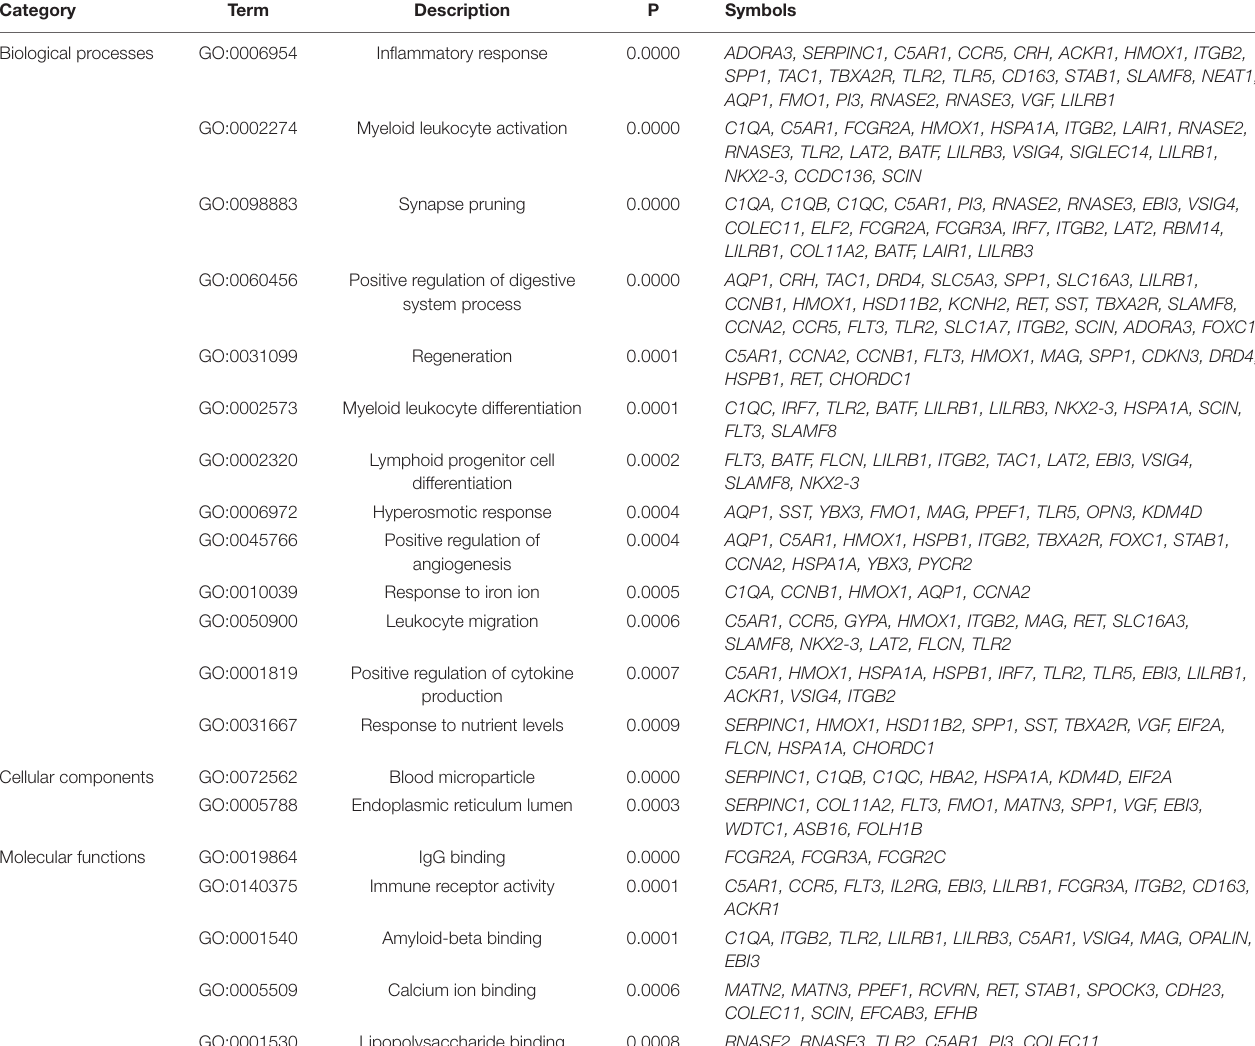
TABLE 2 | Gene ontology (GO) enrichment analysis of the overlapping differentially expressed genes in the frontal cortex and temporal cortex in vascular dementia. Category Term Description P